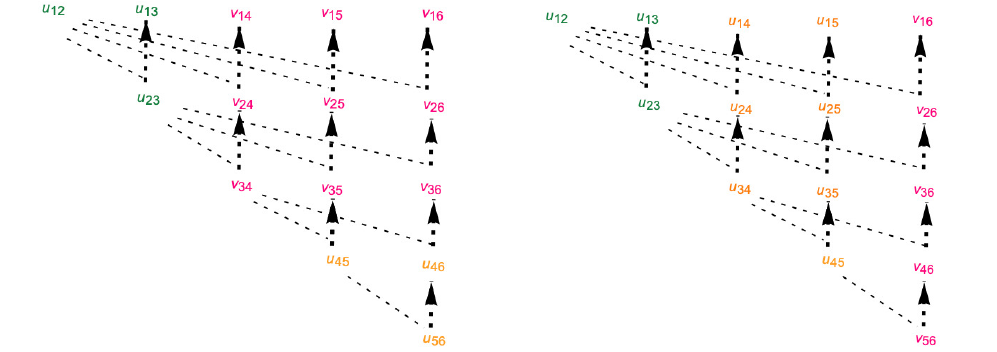
Figure 2 . Two symmetry-breaking patterns. The v 0 s denote variables in the bulk b which are integrated out trivially in the limits to root of unity. The u ’s denote variables along either vector, chiral, or auxiliary bits. Once a distribution of colours is given to the seed elements in the diagonal the colours of the elements in the off-diagonal are implied by the relations (1.34). Chiral and auxiliary walls, which are inverse elements to each other are represented with the same